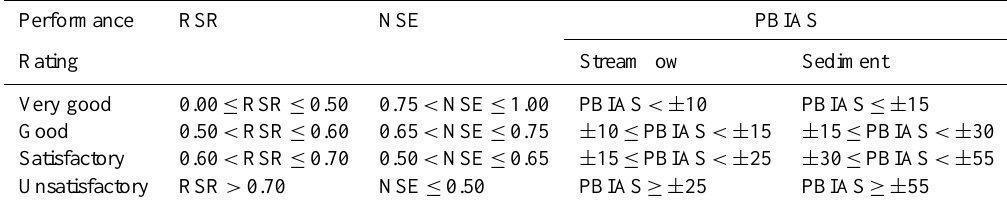
Table 3. General performance ratings recommended by Moriasi et al.